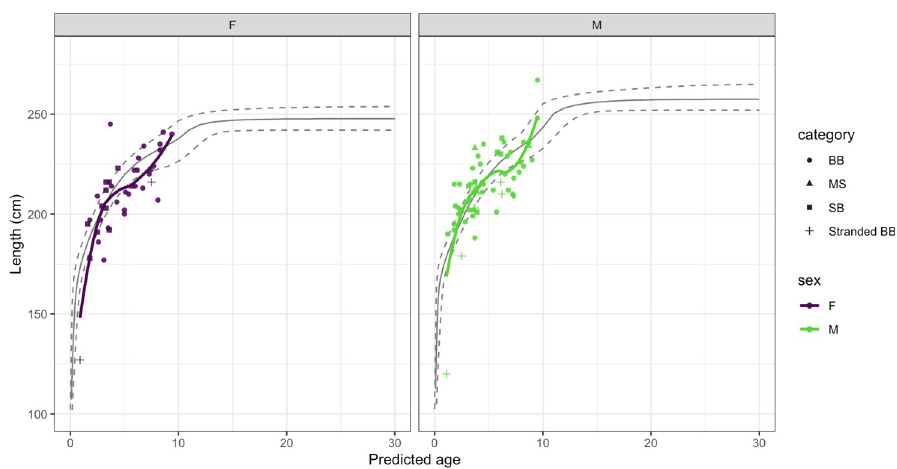
Fig 8. Dental radiography-based age estimates compared to total body length. Data from females are plotted in purple and males are plotted in green. McFee et al. [31] identified three phases of growth in dolphins from Mississippi waters based on GLG age estimates (grey lines represent median fitted values with 95% CI). Although our data set is limited to dolphins generally between the ages of 1–10 years old, the general trend in the periapical age estimates versus length show similar rapid growth of dolphins in this age